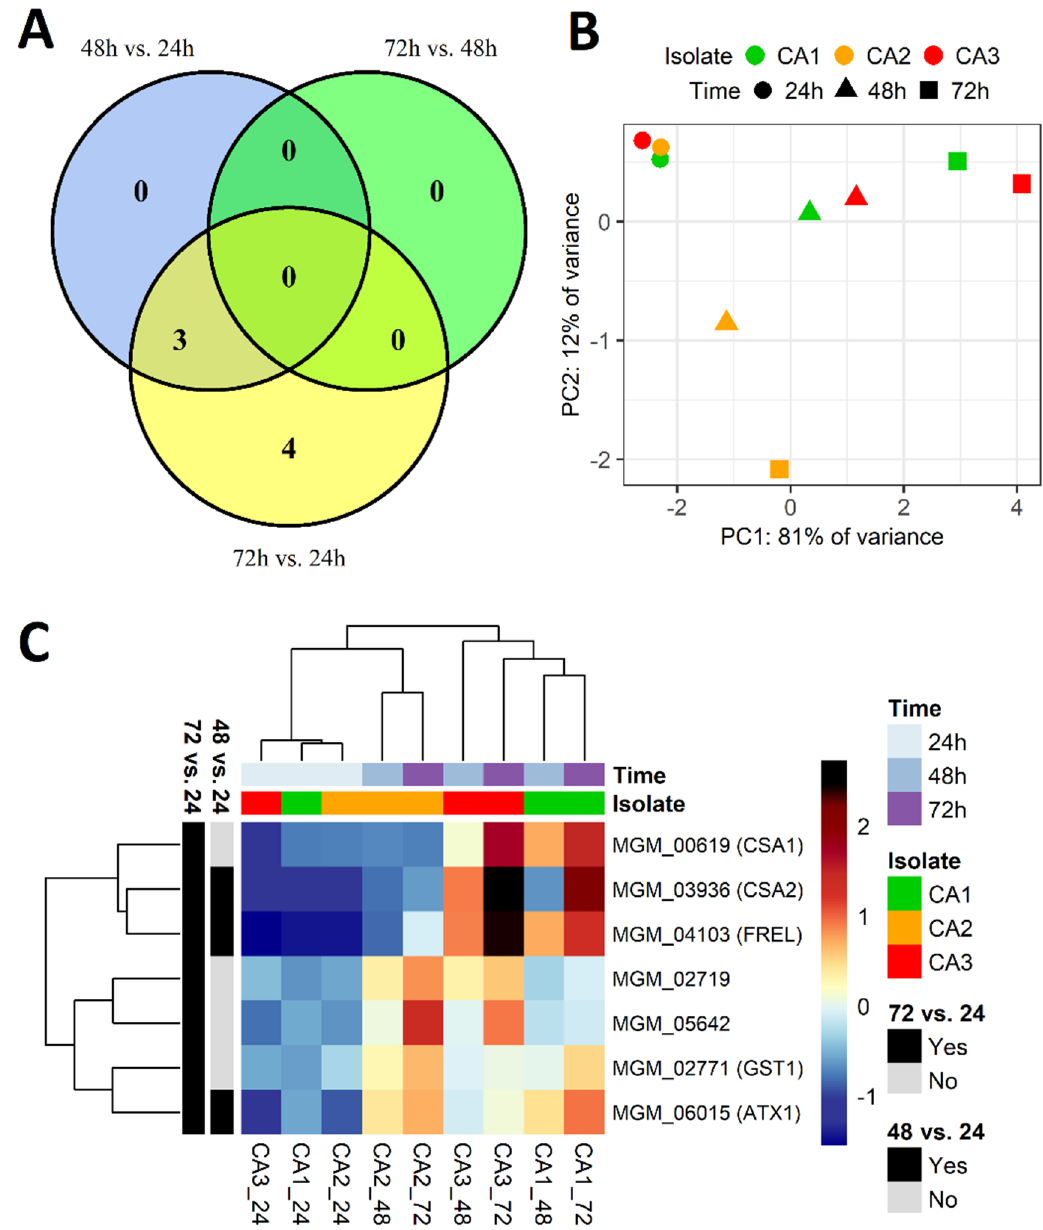
Figure 5. Differential expression of seven genes in Candida albicans isolates (CA1, CA2, CA3) selected from 48 h vs. 24 h, 72 h vs. 48 h, and 72 h vs. 24 h comparisons. ( A ) Venn diagram showing intersections between groups of genes selected from the performed comparisons. There are three genes common for the 48 h vs. 24 h and 72 h vs. 24 h comparisons, while no genes were selected from the 72 h vs. 48 h comparison. ( B ) PCA plot for the expression of seven selected genes. ( C ) Heatmap illustrating the expression of selected genes in the studied samples. Hierarchical clustering was performed using the average method applied to Canberra distances. Table 2. Differential expression characteristics of seven genes selected from comparisons regarding times of incubation in Candida albicans isolates (CA1, CA2, CA3).